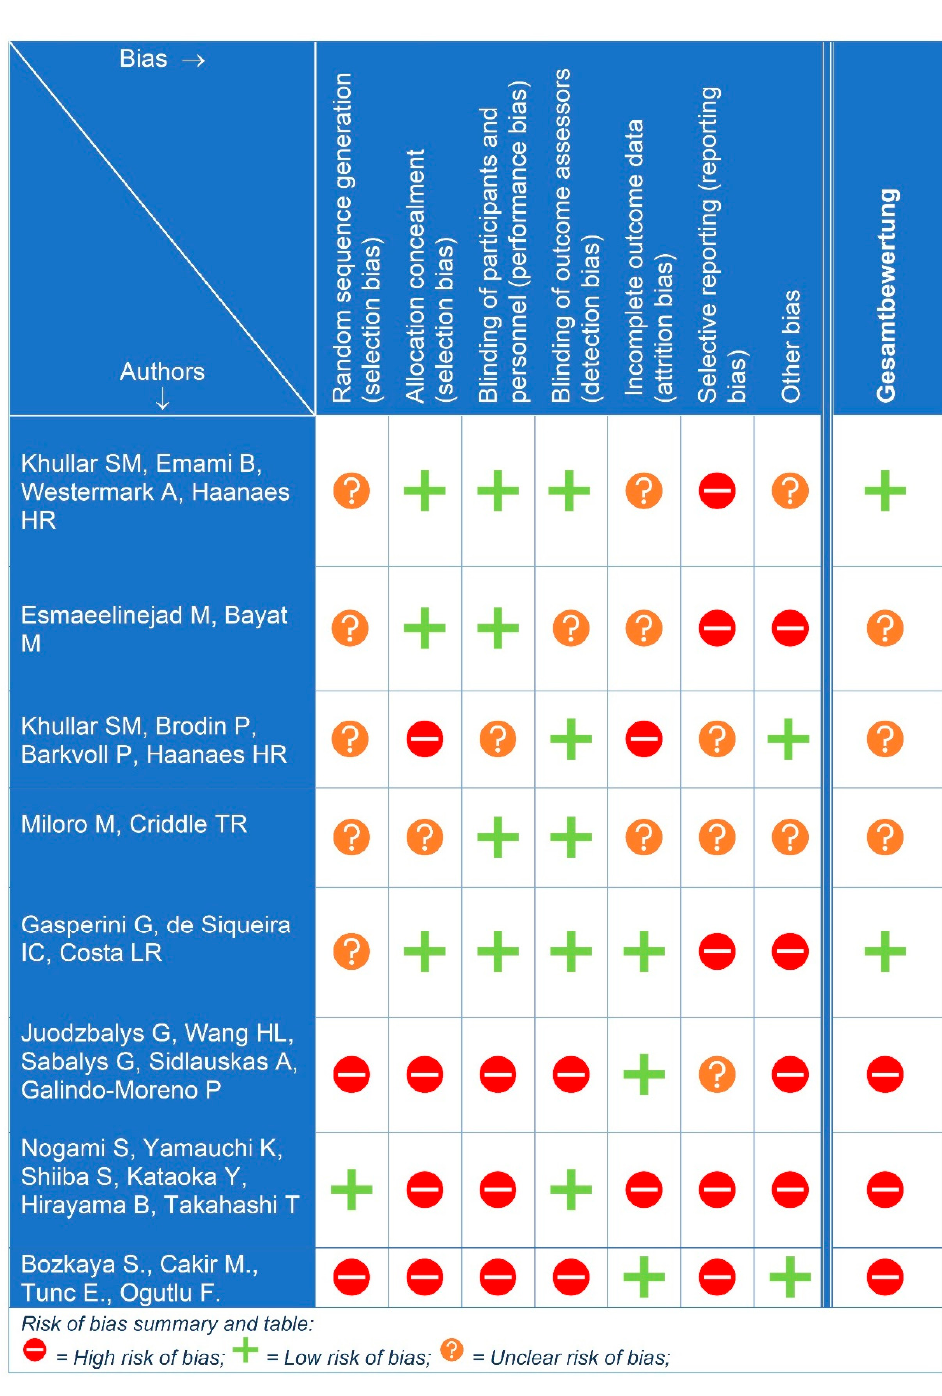
Figure 2. Risk of bias.